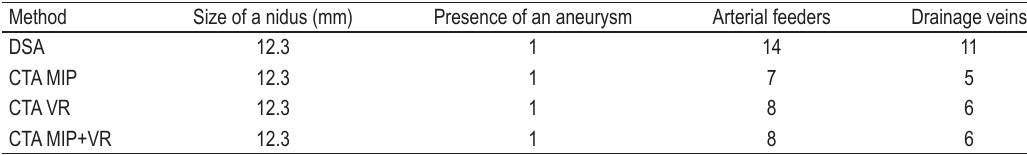
TABLE 2. Correlation between DSA and CTA reconstructions determining size of a nidus, sensitivity to diagnose presence of aneurysm, identifying arterial feeders, and drainage veins Method